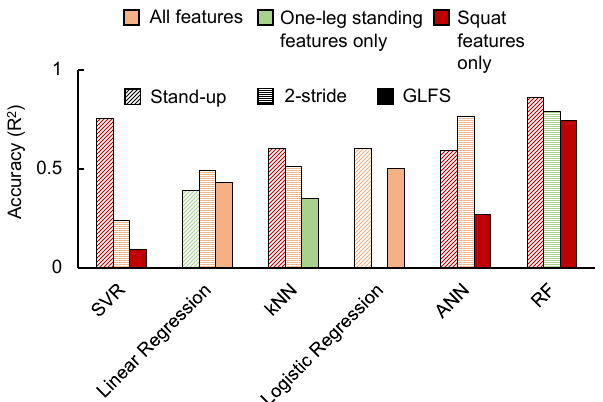
Figure 6. Comparing the accuracy of all classification methods. The accuracy values mentioned here indicate the highest value out of the three considered conditions of parameter selection as indicated by the type of color (all features, squat features only, and one-leg standing features only). The shades indicate the STBLS test scores considered (stand-up, 2-stride, and GLFS-25). In case of the ANN accuracy, we observed that the maximum correlation coefficient between predicted and real scores while using only squat input parameters from i 1 to i 9 was 0.59. On the other hand, while using only one-leg standing parameter inputs from i 10 to i 13 , no correlation between the predicted and actual scores was observed. However, while combining both training set inputs from i 1 to i 13 , an apparent increase in the correlation coefficients was observed for stand-up and 2-stride scores specifically.